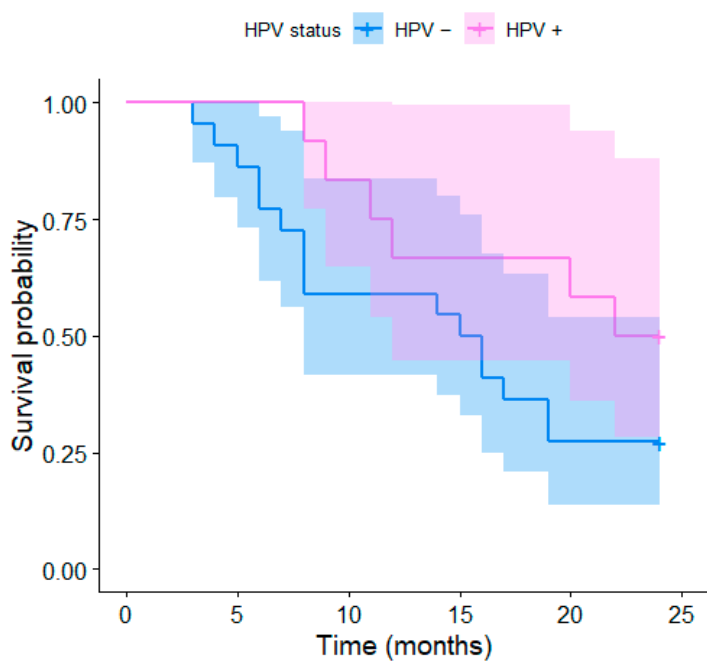
Figure 2. Kaplan–Meier curves of the 2-year survival depending on the HPV status.